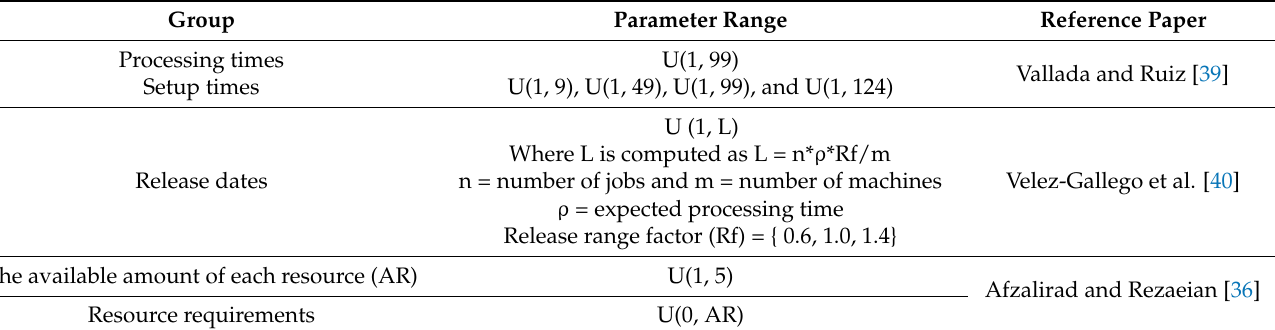
Table 6. The generating conditions of Second test instances.